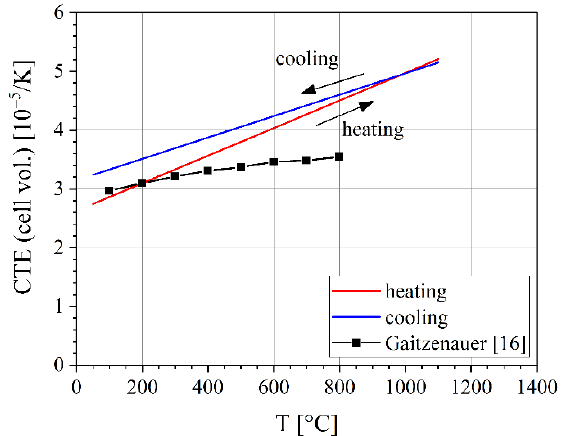
Figure 11. Comparison of the coefficients of thermal expansion (CTE) of the cell volume for the TNM alloy determined from the crystal lattices during heating and cooling at a rate of 20 K min –1 . The mean value over the three phases is weighted with the volume fraction. The results of Gaitzenauer et al. [18] for the bulk are shown for comparison.